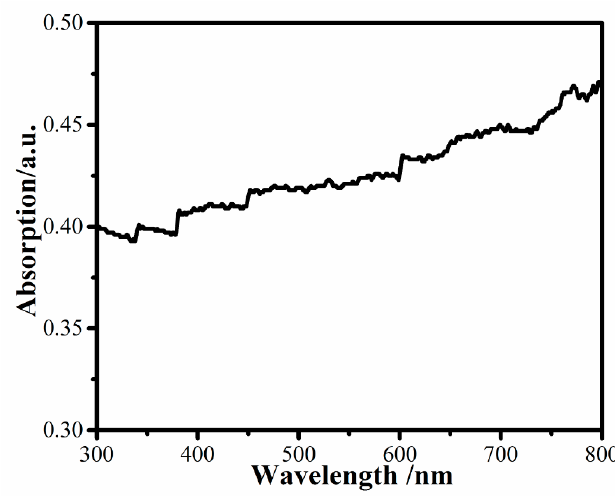
Figure 8. UV–vis spectrum of EP-POSS.